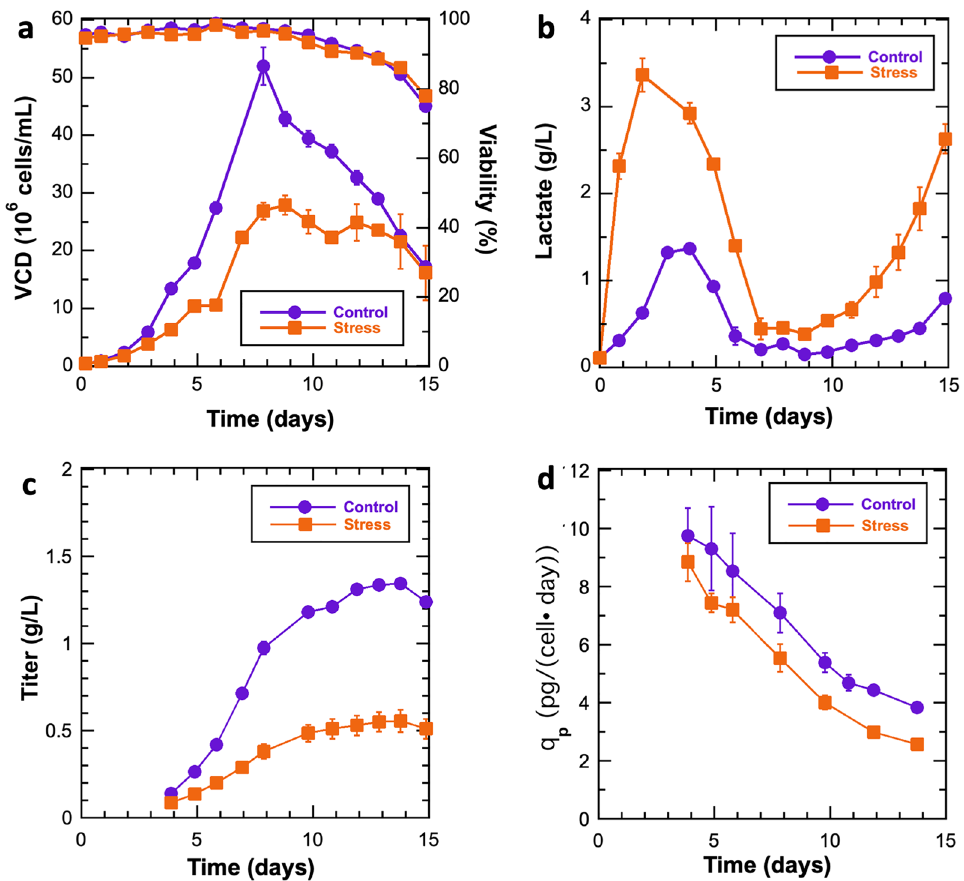
Figure 1. Growth characteristics for control and lactate-stressed CHO cell cultures. ( a ) Viable cell density (VCD) (10 6 cells/mL) and cell viability (%), ( b ) Lactate (g/L), ( c ) Titer (g/L), and ( d ) Cell-specific productivity (pg/cell•day). Control cultures (purple circles) and stressed cultures (orange squares) N = 2. Error bars represent standard